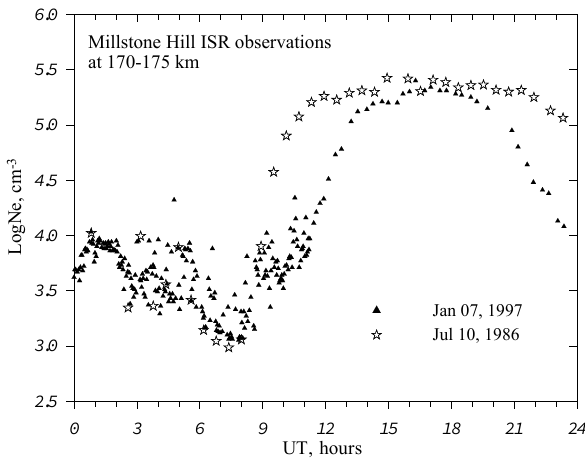
Figure 5 Fig. 5. Observed with the Millstone Hill ISR diurnal variations of Ne in the F1-region (170–175km) for winter and summer magneti- cally quiet days under solar minimum